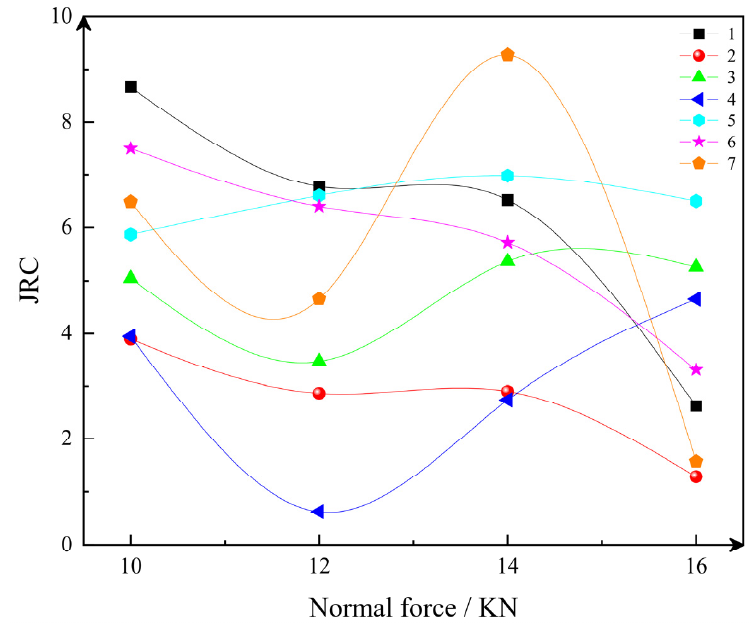
Figure 18. JRC value of the damage surface.